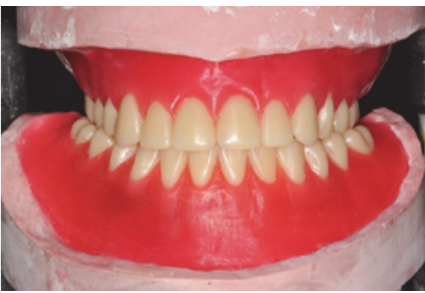
Figure 6: The teeth setup in